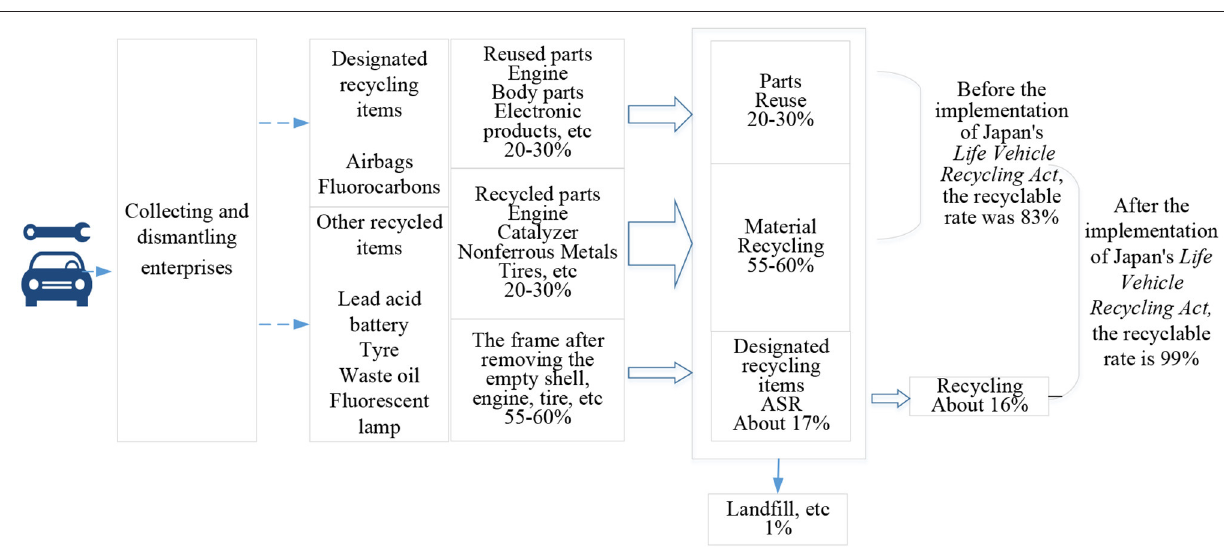
FIGURE 7 | Materials flow analysis of ELVs in